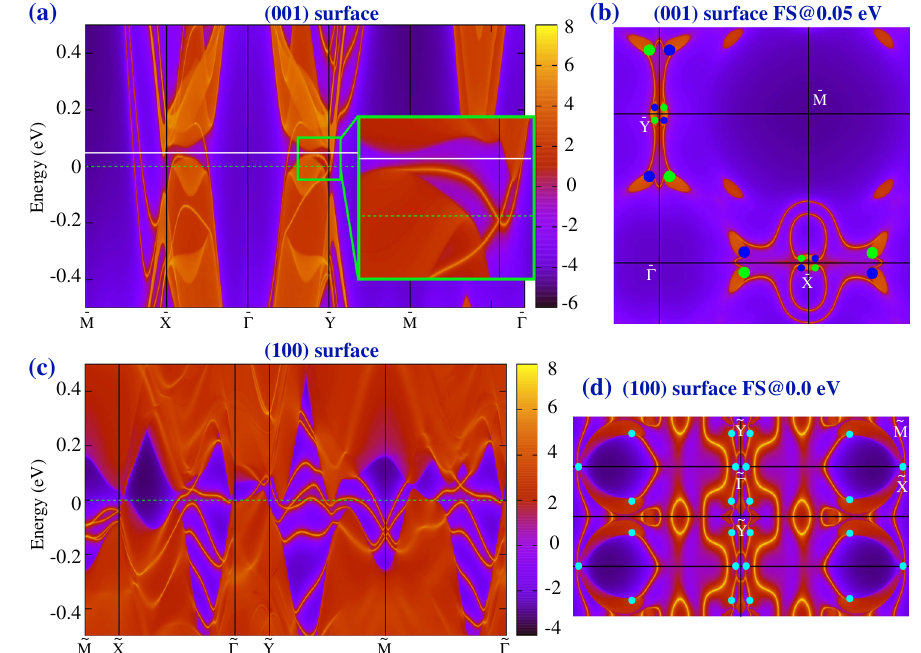
FIG. 4. Fermi arcs in the surface states. (a) The Surface states for (001) surface; (b) the corresponding fermi surfaces on (001) surfaces; (c) The Surface states for (100) surface. The dots illustrate the projective points of the bulk Weyl points on the surfaces, where the color represents the chirality of the Weyl points (blue for positive and green for negative), small dot represents the single projected Wely point, and large dot represents two Weyl points with same chirality projecting on top of each other. (d) the corresponding fermi surfaces on (100) surfaces. All the dots here are the projective points for a pair of Weyl points with opposite